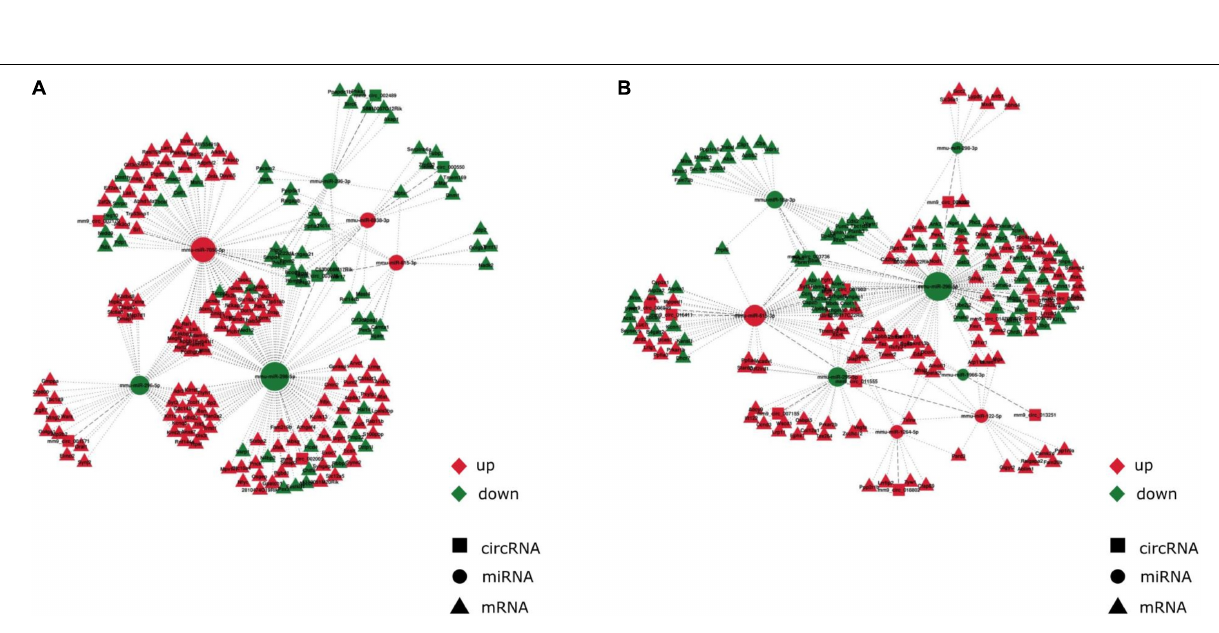
Frontiers in Aging Neuroscience | www.frontiersin.org